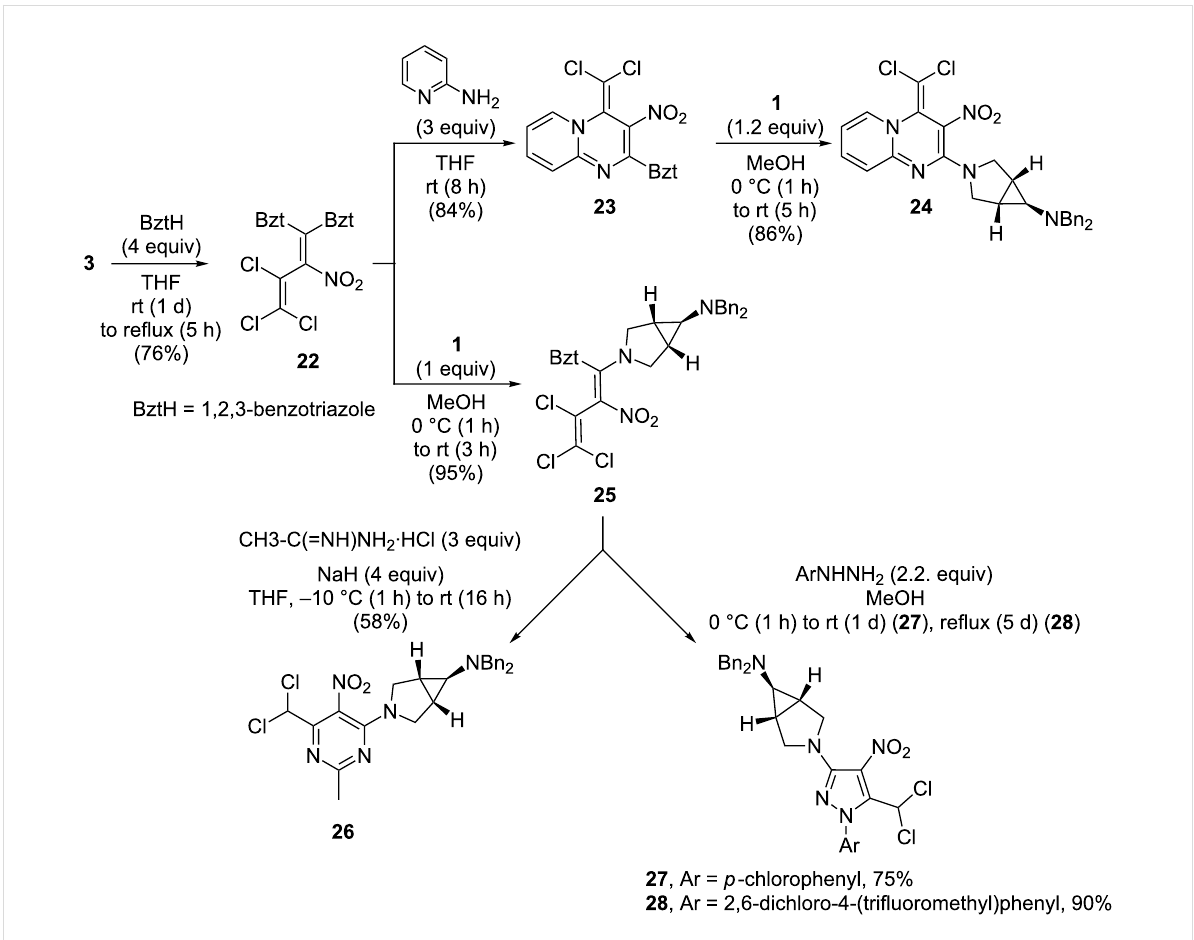
Scheme 6: Preparation of the pyrazoles 27 , 28 , the pyrimidine 26 and the pyridopyrimidine 24